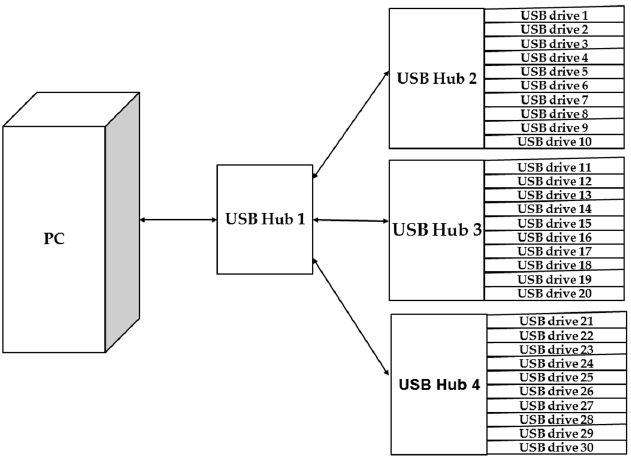
Figure 4. The experiment for massive deployment of USB flash drives: A USB 3.0 hub was used as the main hub; three other USB 3.0 hubs were connected to the main hub; each one of the three USB 3.0 hubs was used to connect 10 USB flash